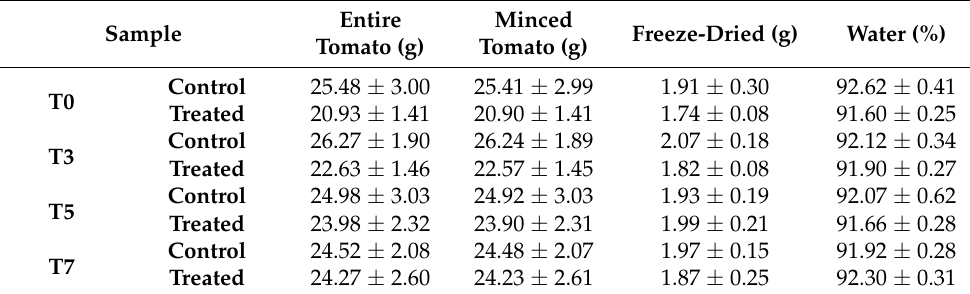
Table 2. Weights of entire, minced and freeze-dried tomatoes coated or not with TYR2 formulation, and water percentage inside the control and treated tomatoes at different times from treatment with the edible film coating (mean ± SE, n = 5). Entire Minced Sample Tomato (g) Tomato